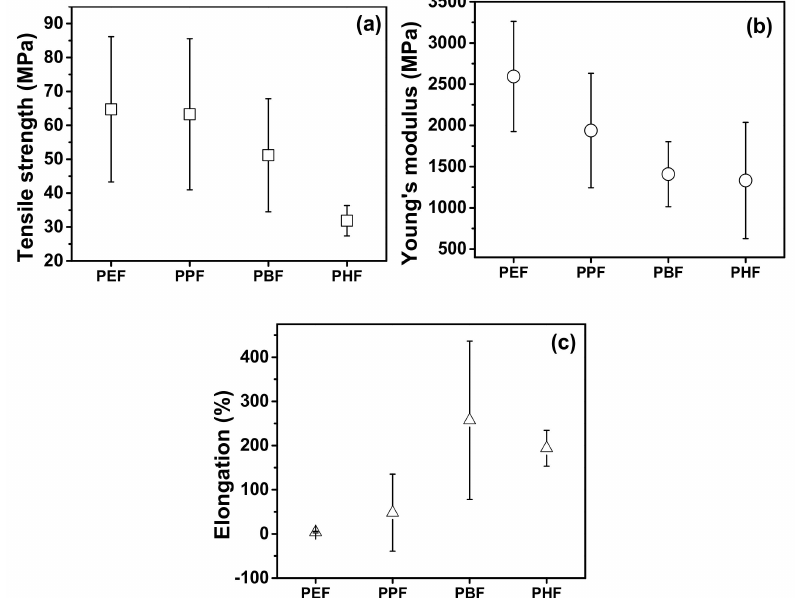
Figure 12. Summary of the e ff ect of the number of methylene groups on the ( a ) tensile stress at break, ( b ) Young’s modulus and ( c ) elongation at break of FDCA-based polyesters (average values from Table